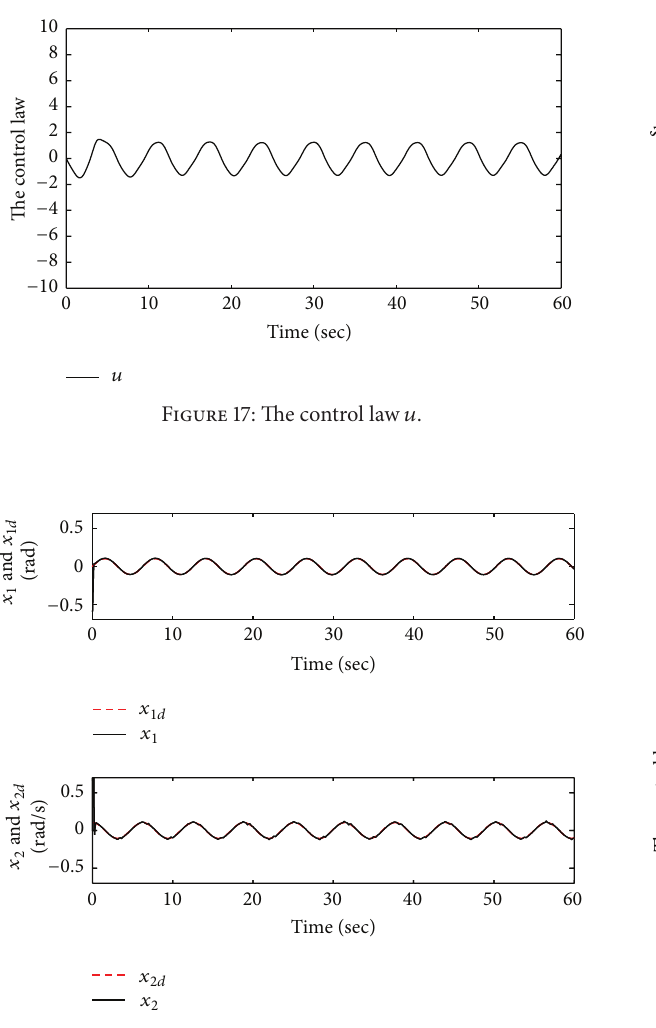
Figure 18: The tracking performances of 𝜃 and